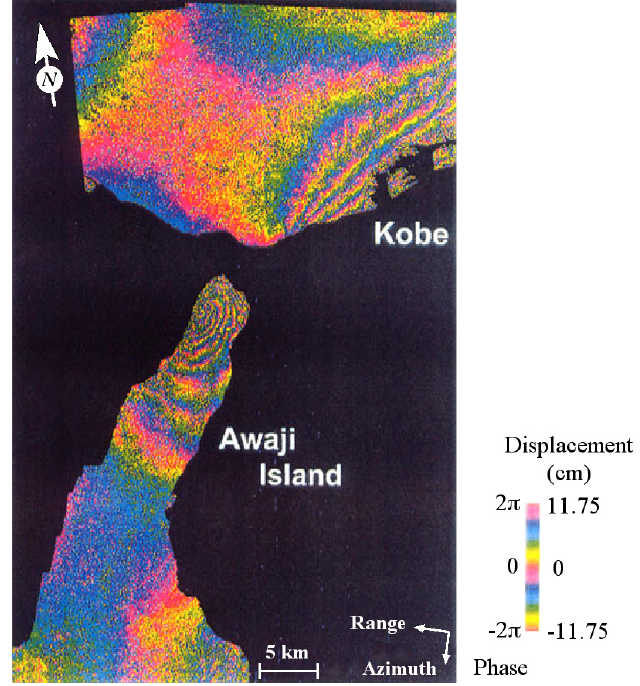
JERS-1 SAR DInSAR phase image showing the crust movement caused